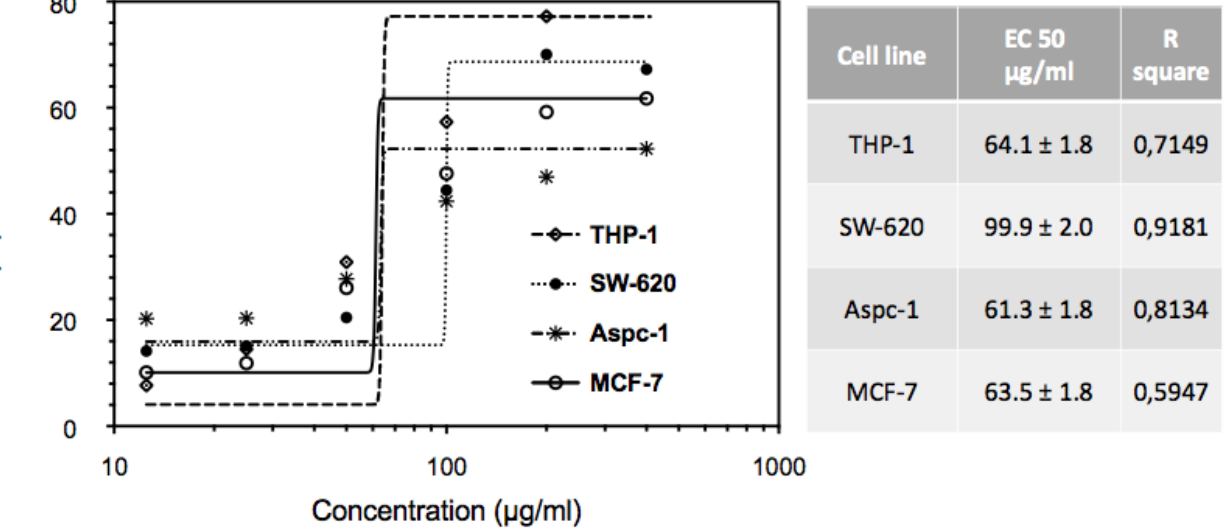
Figure 5. Dose-dependent induction of apoptosis by EHA-Aq fraction (12.5–200 µ g/mL) in different phenotypes of human cancerous cell lines. After 24 h of treatment, apoptosis induction was analyzed by flow cytometry. Percentages of apoptotic cells were used to calculate EC 50 values using GraphPad Prism 6 software.